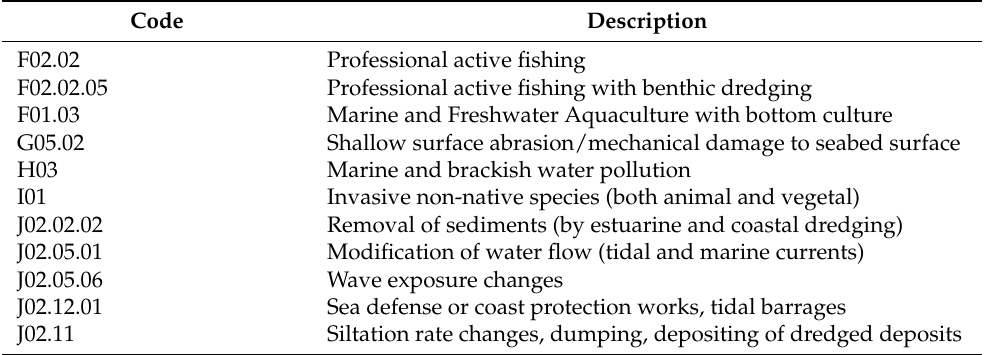
Table 1. Main factors of pressure and disturbance acting on seagrasses, identified and coded dur- ing the activities of the DG Environment and the European Environment Agency concerning the implementation of European Directives Habitat (92/43/EEC) and Birds (2009/147/EC)